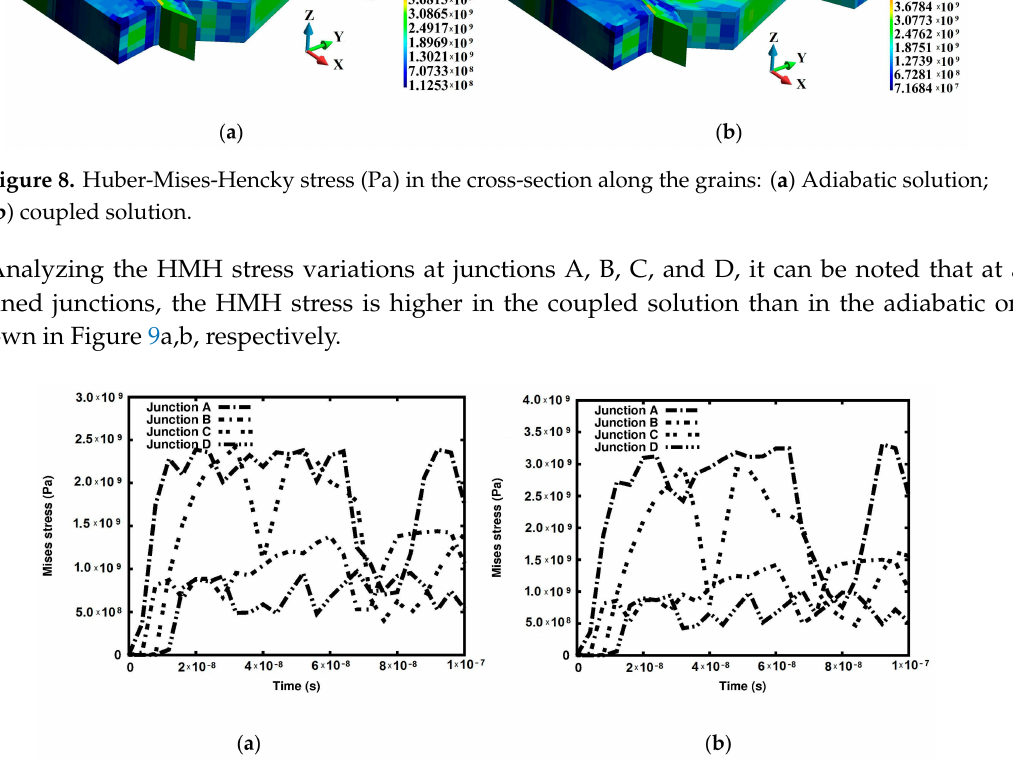
Figure 9. Variations in the Huber-Mises-Hencky stress (Pa) at the junctions: ( a ) Adiabatic solution; ( b ) coupled